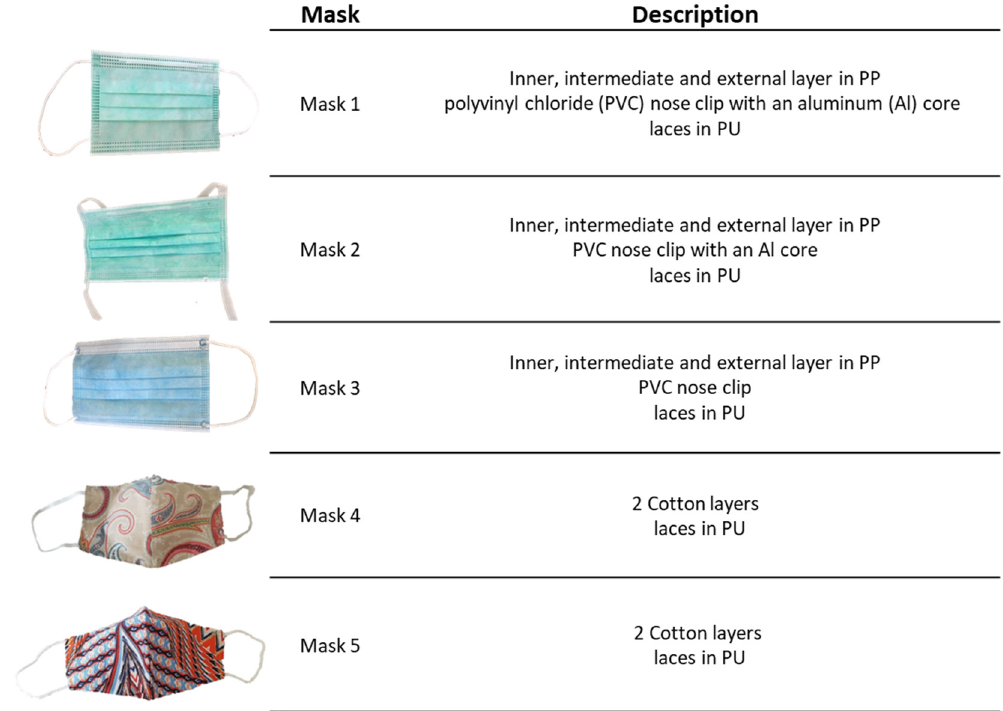
Figure 2. Different masks typologies: three different surgical masks, two different fabric masks.